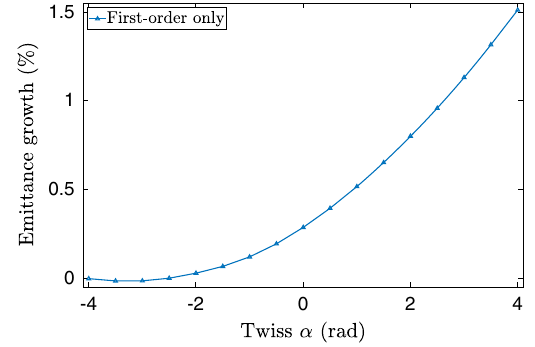
FIG. 3. Emittance growth ratio as a function of initial Twiss α obtained by ELEGANT simulation. In this scan, initial Twiss β is fixed to 0.1 m.